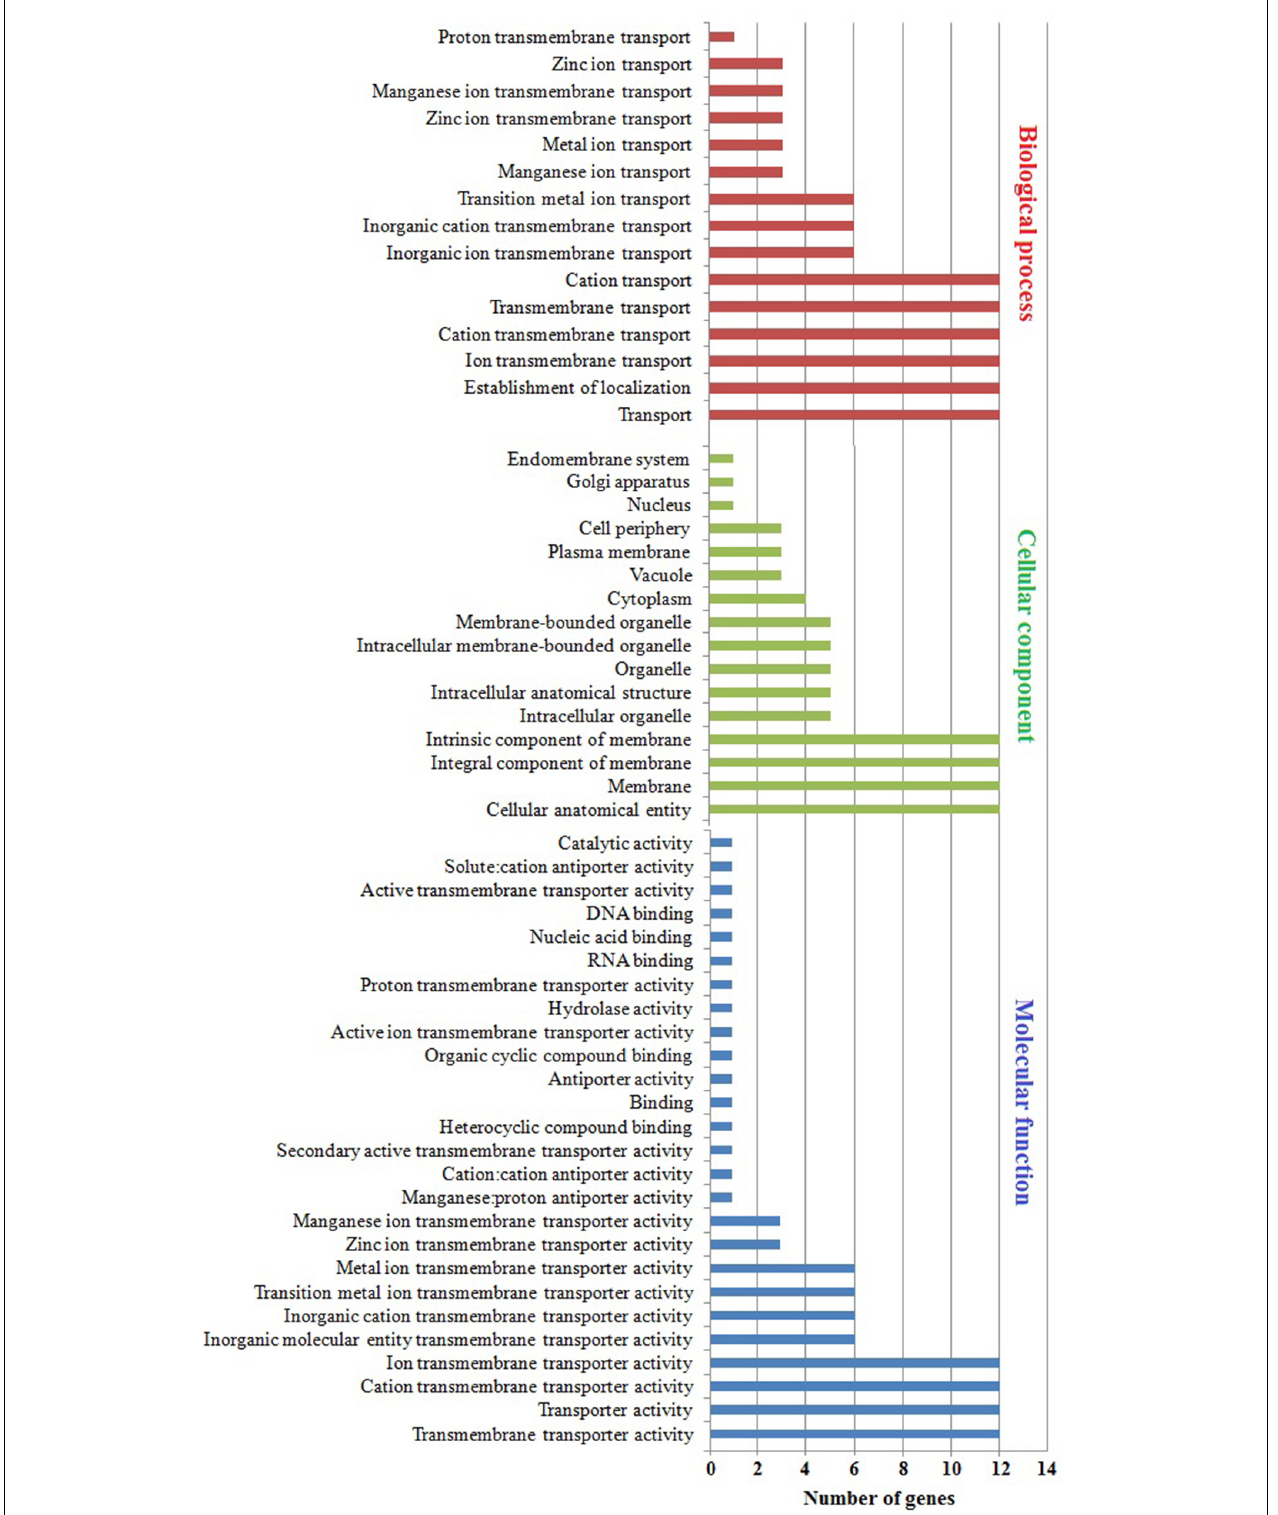
FIGURE 7 | Gene ontology analysis of M. truncatula MTP genes. Gene ontology showed the distribution of every MtMTP gene in the plant, where a red-colored column shows the cellular component. Conversely, the biological processes in which the MTP family participate are shown by a blue-colored column, and the molecular function is shown by a mauve